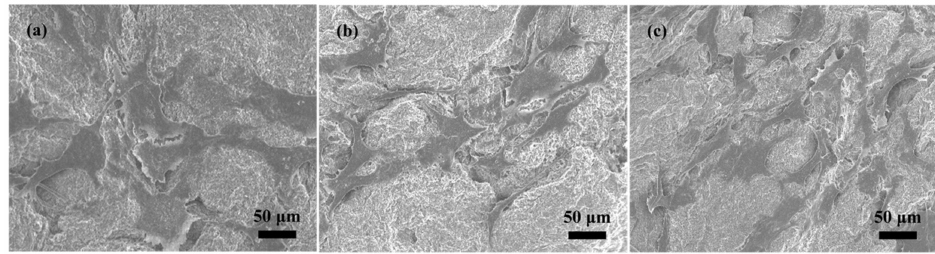
Figure 9. Morphology of the hBMSCs after culture on nanofiber scaffold for ( a ) 1, ( b ) 4, and ( c ) 7